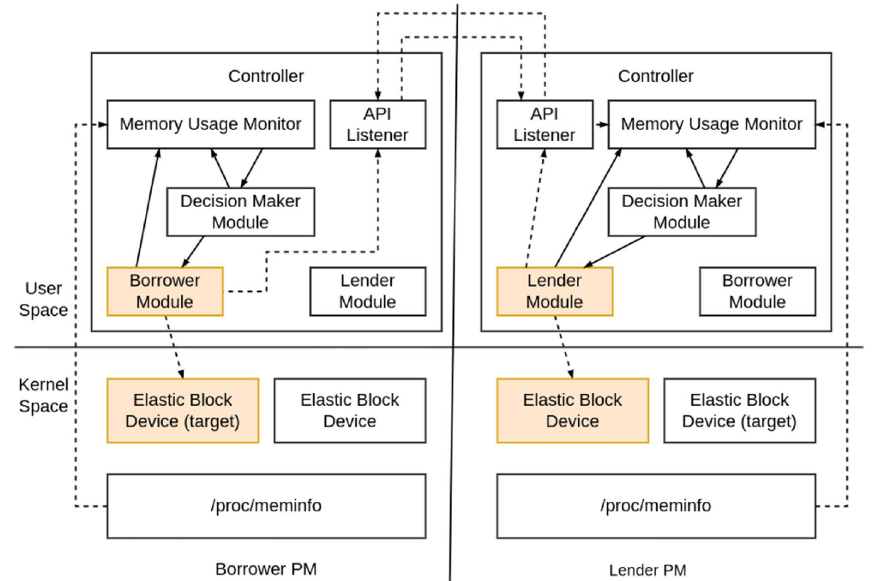
Fig. 6 Implementation of memory sharing in user and kernel spaces on each PM. Solid arrows represent state transition between four modules: memory usage monitor, decision maker module, borrower module, and lender module. Dashed arrows represent input for triggering state